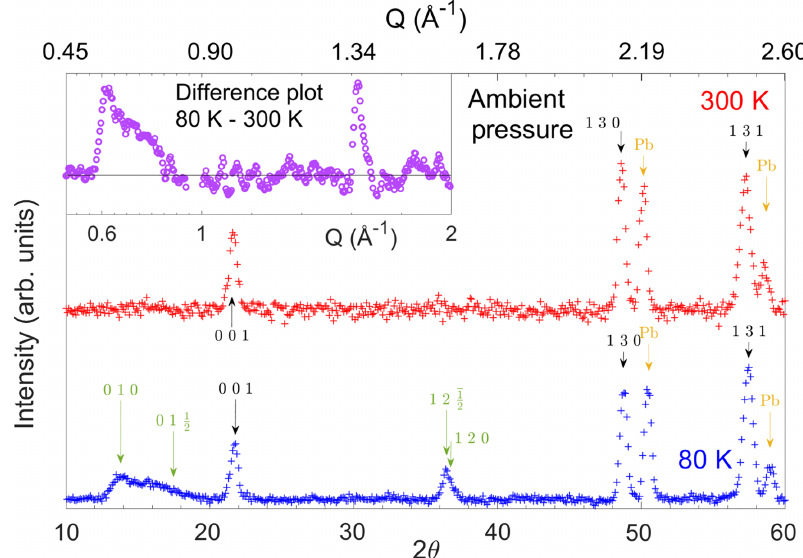
FIG. 3. Powder neutron diffraction patterns of FePS 3 at ambient pressure at 80 and 300 K taken on D20, ILL. Nuclear and magnetic Bragg peaks are marked (magnetic in green) as indexed in the monoclinic low-pressure phase. The magnetic propagation vector at Þ , but strain and stacking faults in the crystal due to grinding lead to 2D rodlike ordering with vector ambient pressure is k ¼ ð 0 ; 1 ; 1 2 k ¼ ð 0 ; 1 ; 0 Þ , as described in Refs. [11,13,19]. This ordering causes the broad and asymmetric peak visible at small Q in the 80 K data. ¯ 1 An additional magnetic feature at higher Q can be indexed as the 1 2 0 and/or the 1 2 . The broad diffuse background of the methanol- 2 ethanol pressure medium is subtracted from all plots shown. The inset shows the result of subtracting the 300 K data from the 80 K plotted against Q to reveal the solely magnetic